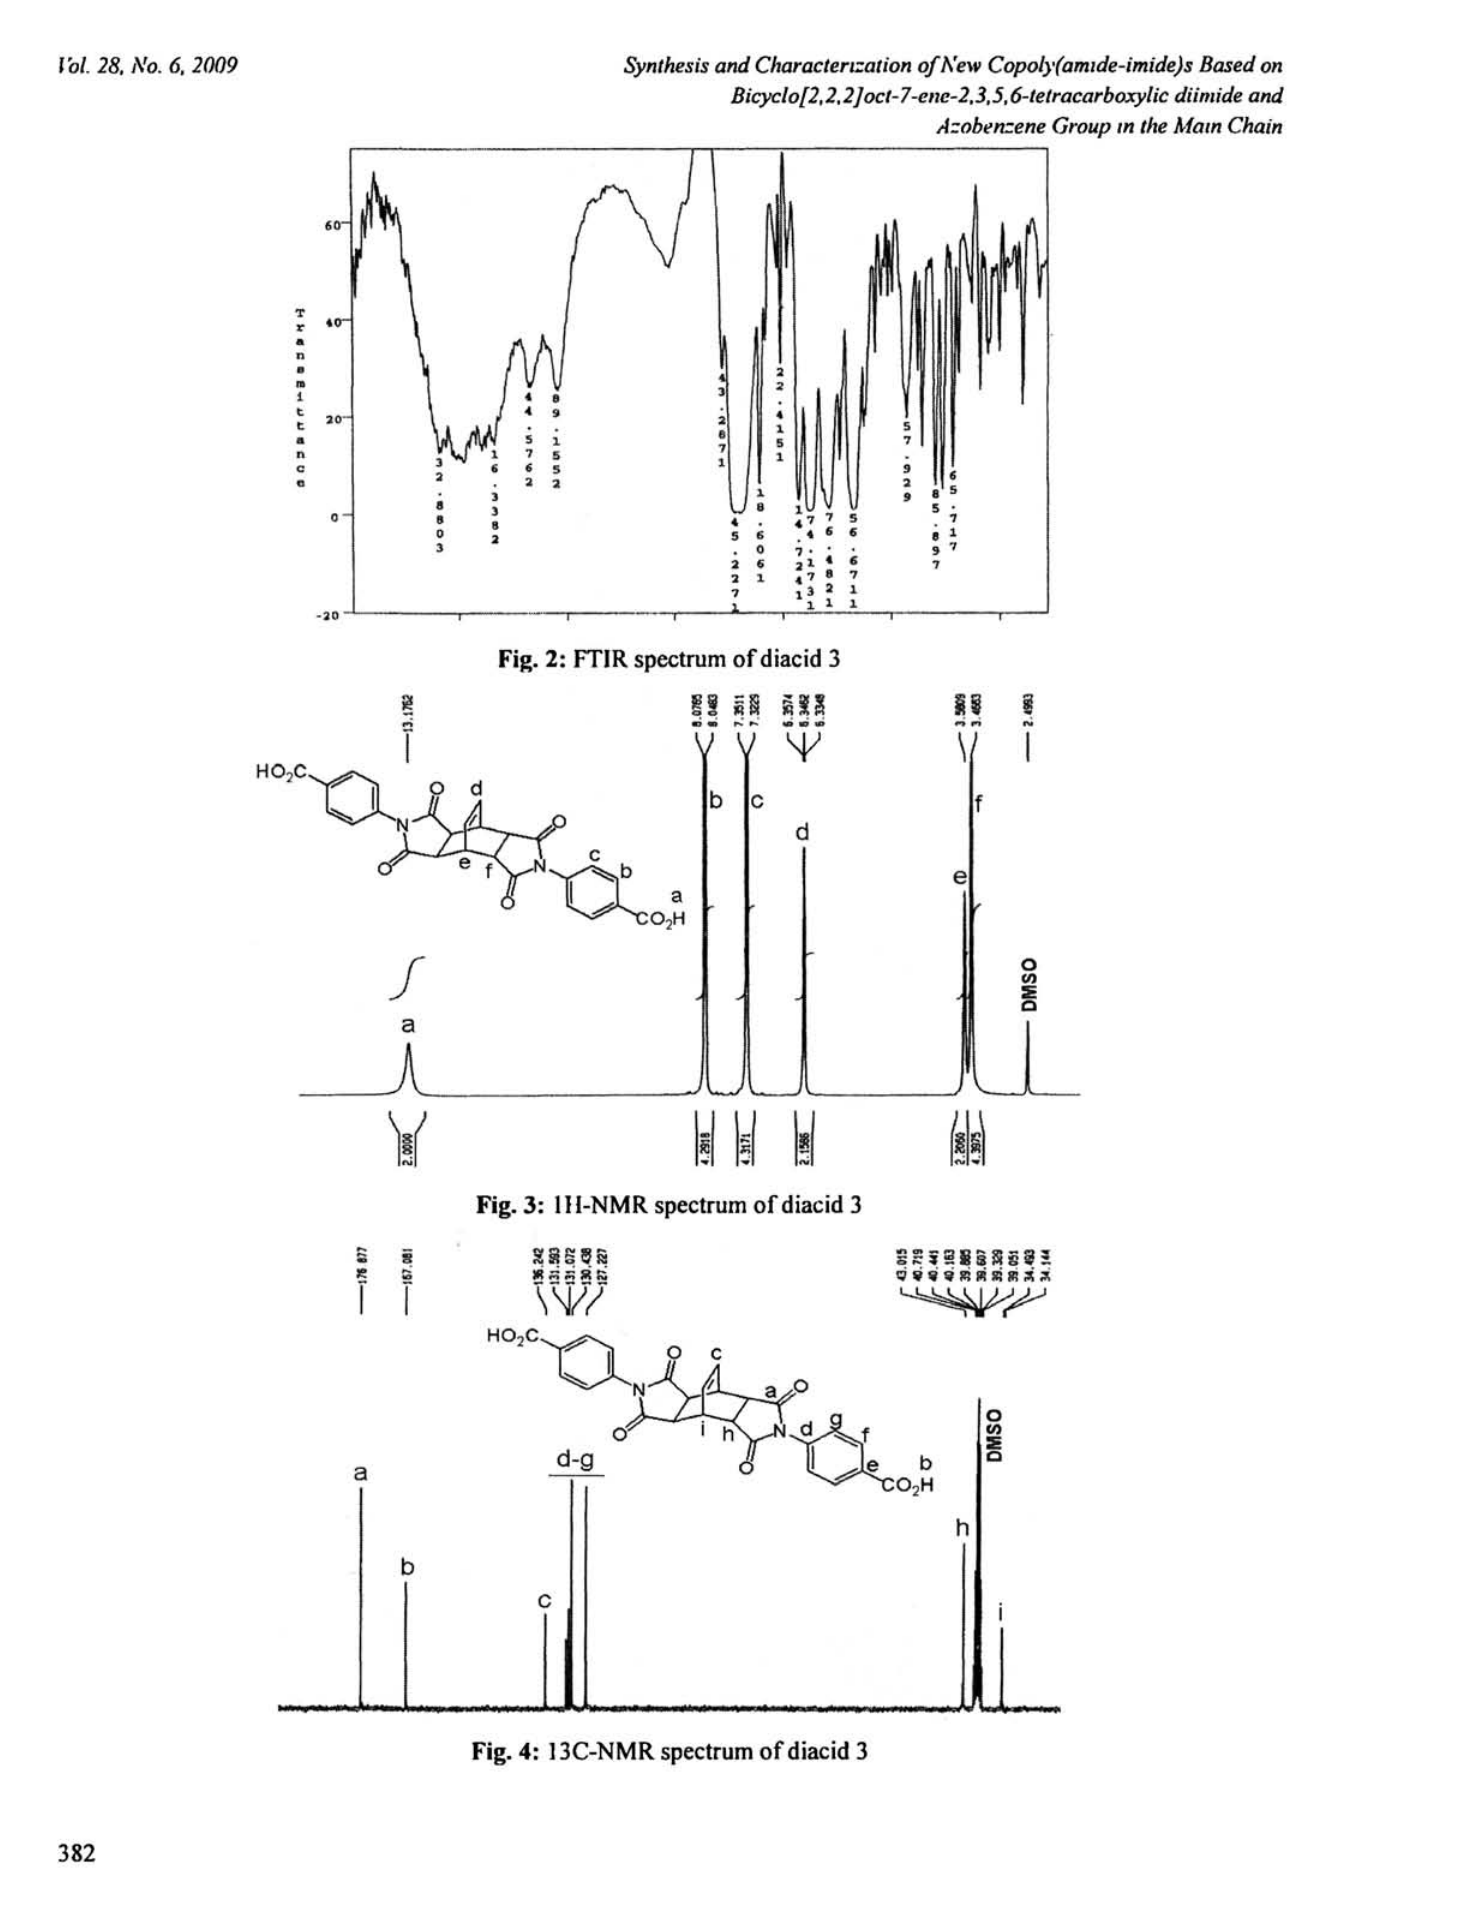
Fig. 2: FTIR spectrum of diacid 3